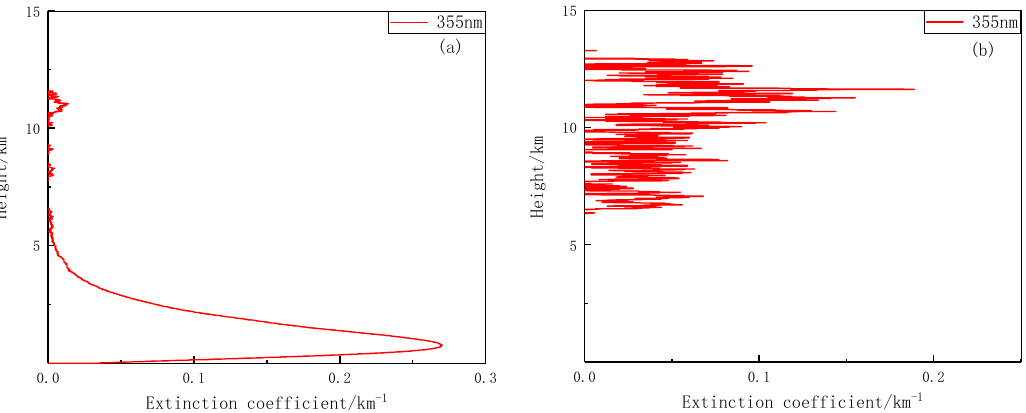
Figure 1. Aerosol extinction coefficient profile: ( a ) with discontinuity and ( b ) with many negative values.